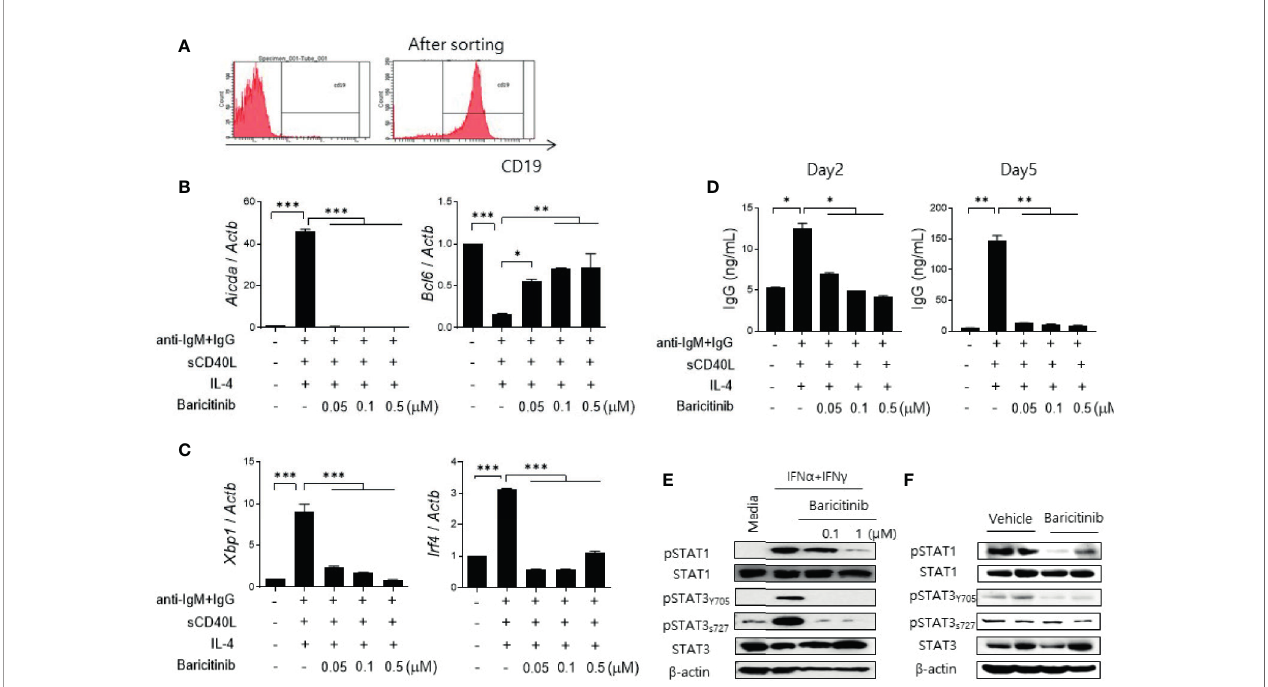
FIGURE 5 | Baricitinib suppresses B cell differentiation and IgG production in vitro . (A) Representative fl ow cytometric image showing CD19+ B cells isolated from spleens of C57BL/6 mice. (B) B cells (5 × 10 5 cells per well) treated with 1 m g/mL IgM antibodies, 250 ng/mL sCD40L, and 100 ng/mL IL-4 for 2 days with or without graded dose of baricitinib. mRNA levels of Aicda , and Bcl6 were determined using real-time PCR. (C) B cells were treated with the same condition for 5 days. mRNA levels of Xbp1 and Irf4 were determined using real-time PCR. (D) Levels of IgG in culture supernatant were measured by ELISA. (E) CD19+ B cells treated with 100 U/mL IFN- a and 20 ng/mL IFN- g for 30 minutes with or without baricitinib. Expression levels of pSTAT1, STAT1, pSTAT3 (Tyr705, Ser727), and STAT3 are shown. (F) Expression levels of pSTAT, STAT1, pSTAT3 (Tyr705, Ser727), and STAT3 in CD19+ B cells from 16-week MRL/ lpr mice in vivo treated with baricitinib or vehicle. These western blot data are representatives of three independent experiments. Bars indicate mean ± SD. * p < 0.05; ** p < 0.01; *** p <